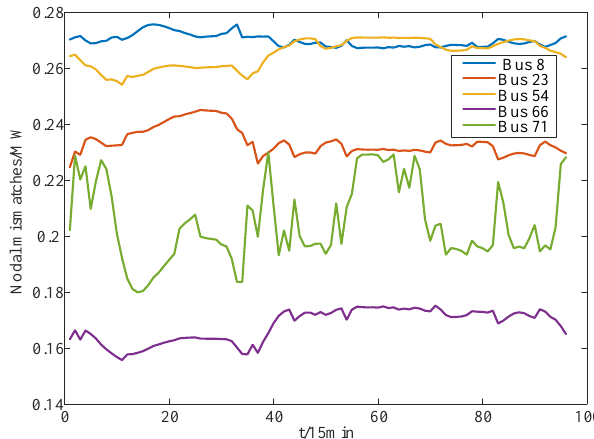
Figure 10. The five maximum nodal active power mismatches of different buses.